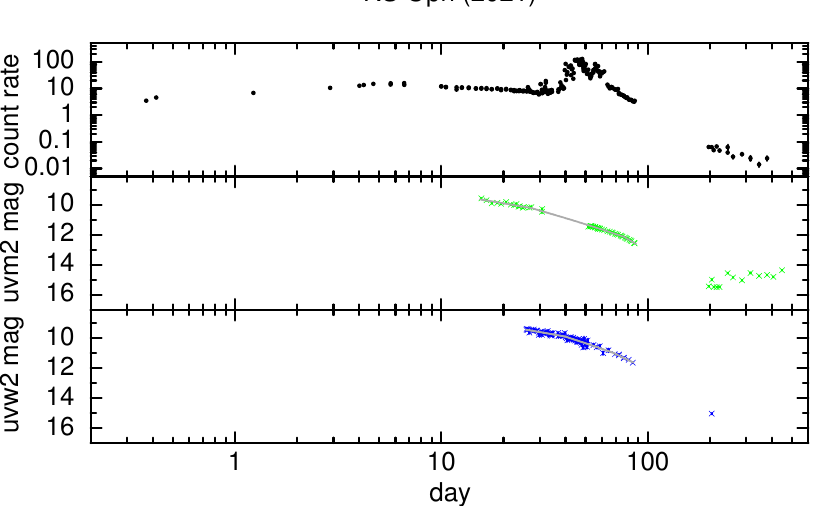
Figure 13. The XRT and UVOT light-curves of RS Oph, with the best-fit broken power-law declines shown as the grey solid lines. Only the UVOT data before the first solar conjunction have been fitted. The X-ray data (top) are in count s − 1 over 0.3–10